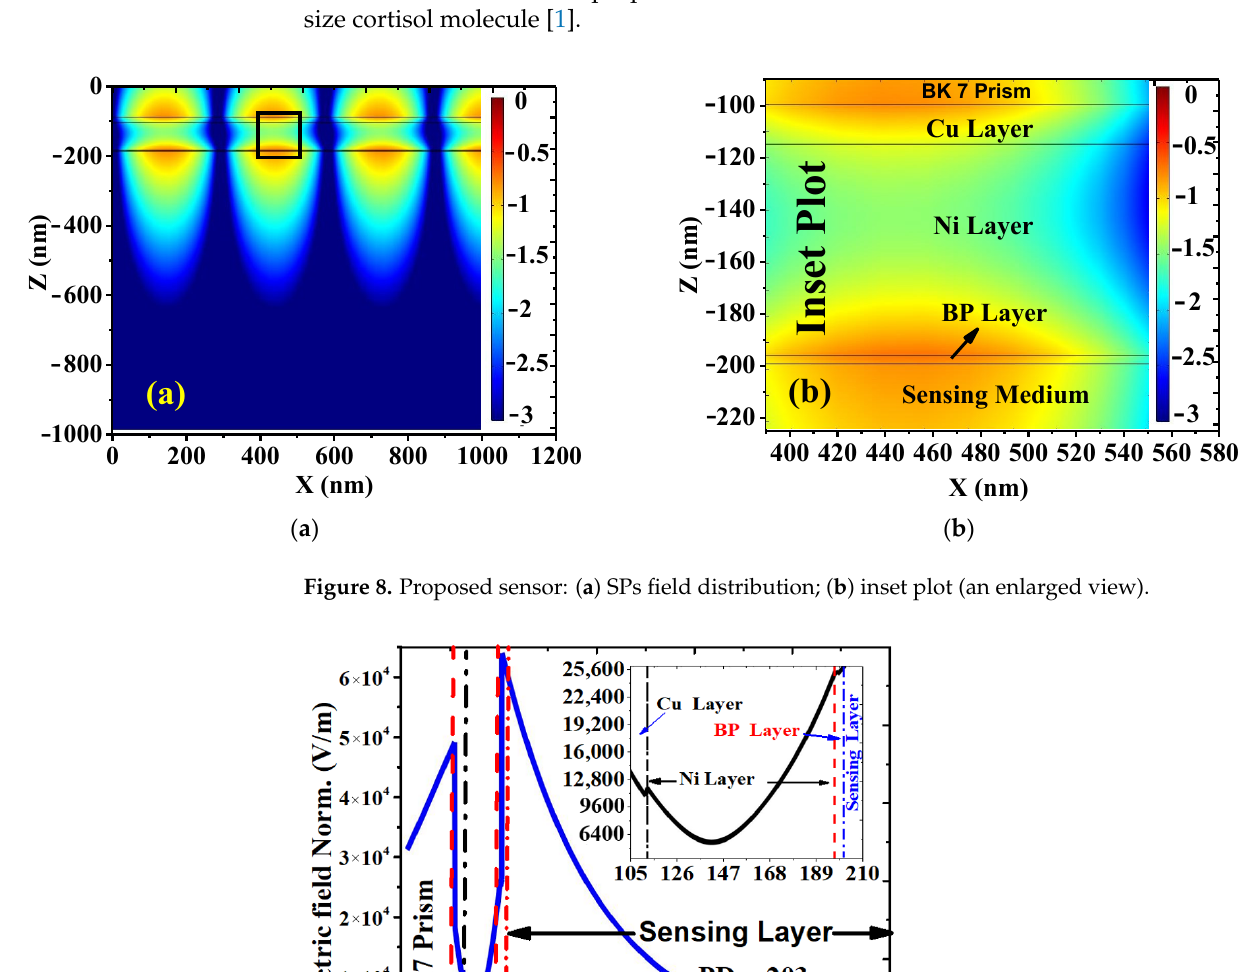
Table 3. Performance parameters at different cortisol concentrations. Cortisol Conc.